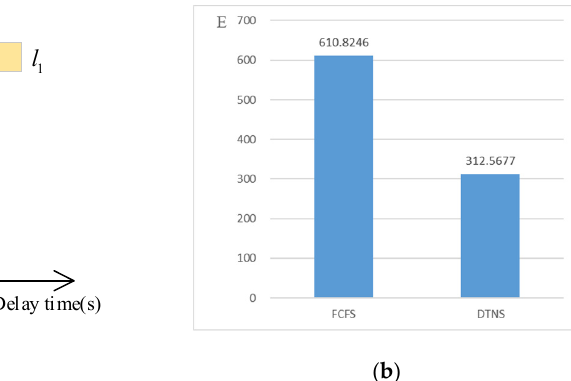
Table 12. Paths obtained by FCFS and DTNS under the condition of three robot-trailer in scenario 2. Robot-Trailer